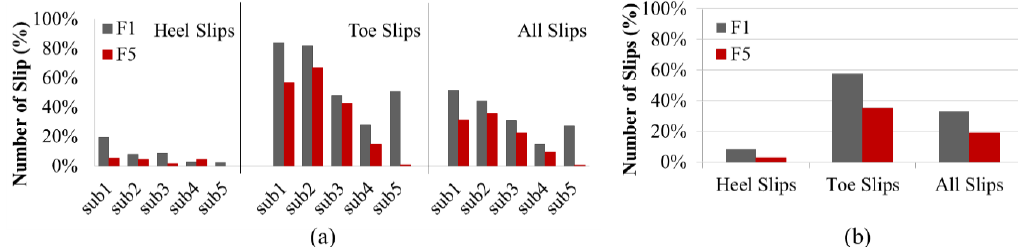
Figure 13. ( a ) The number of slips per participant with F1 and F5, ( b ) Total number of slips from all participants with F1 and F5.